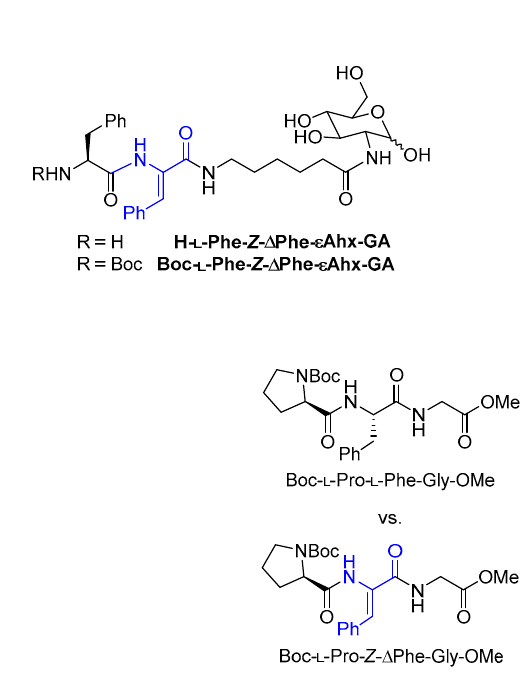
Figure 5. Summary of dehydrodipeptides modified at the C -terminus.